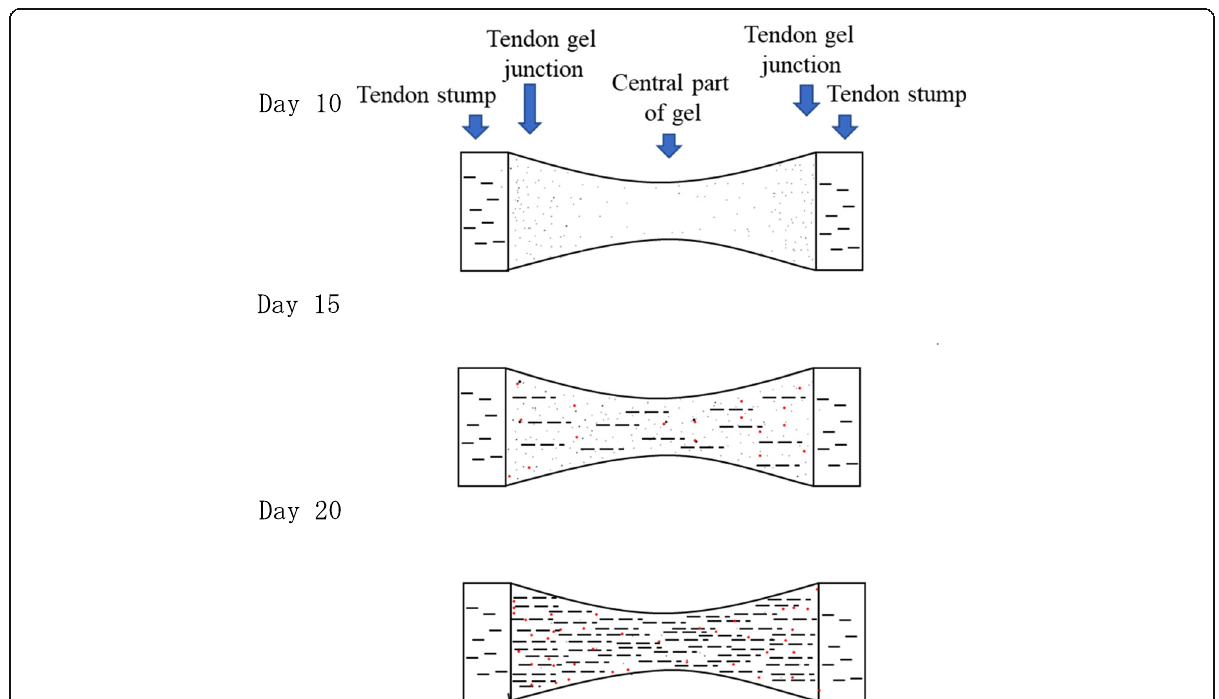
Fig. 7 Scheme of cell and fiber distribution changes. The trend of the local existence of cells and fibers. Black dot: round cells, red dot: flat cells, black line: collagen